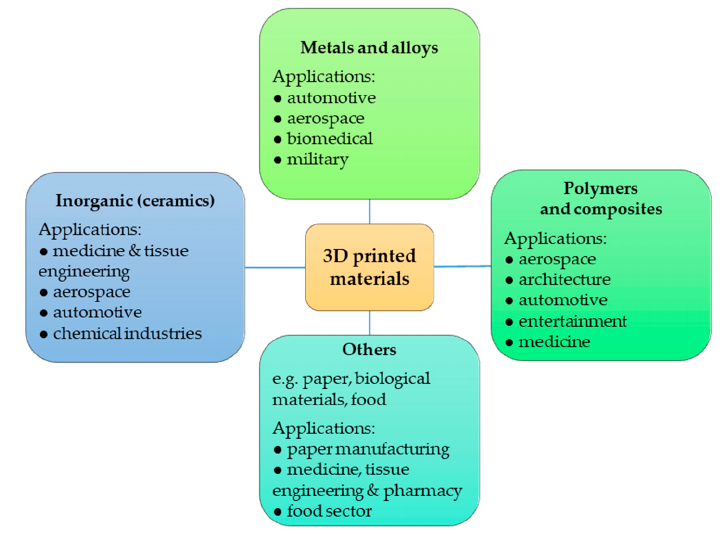
Figure 1. Three-dimensional-printed materials and their applications.